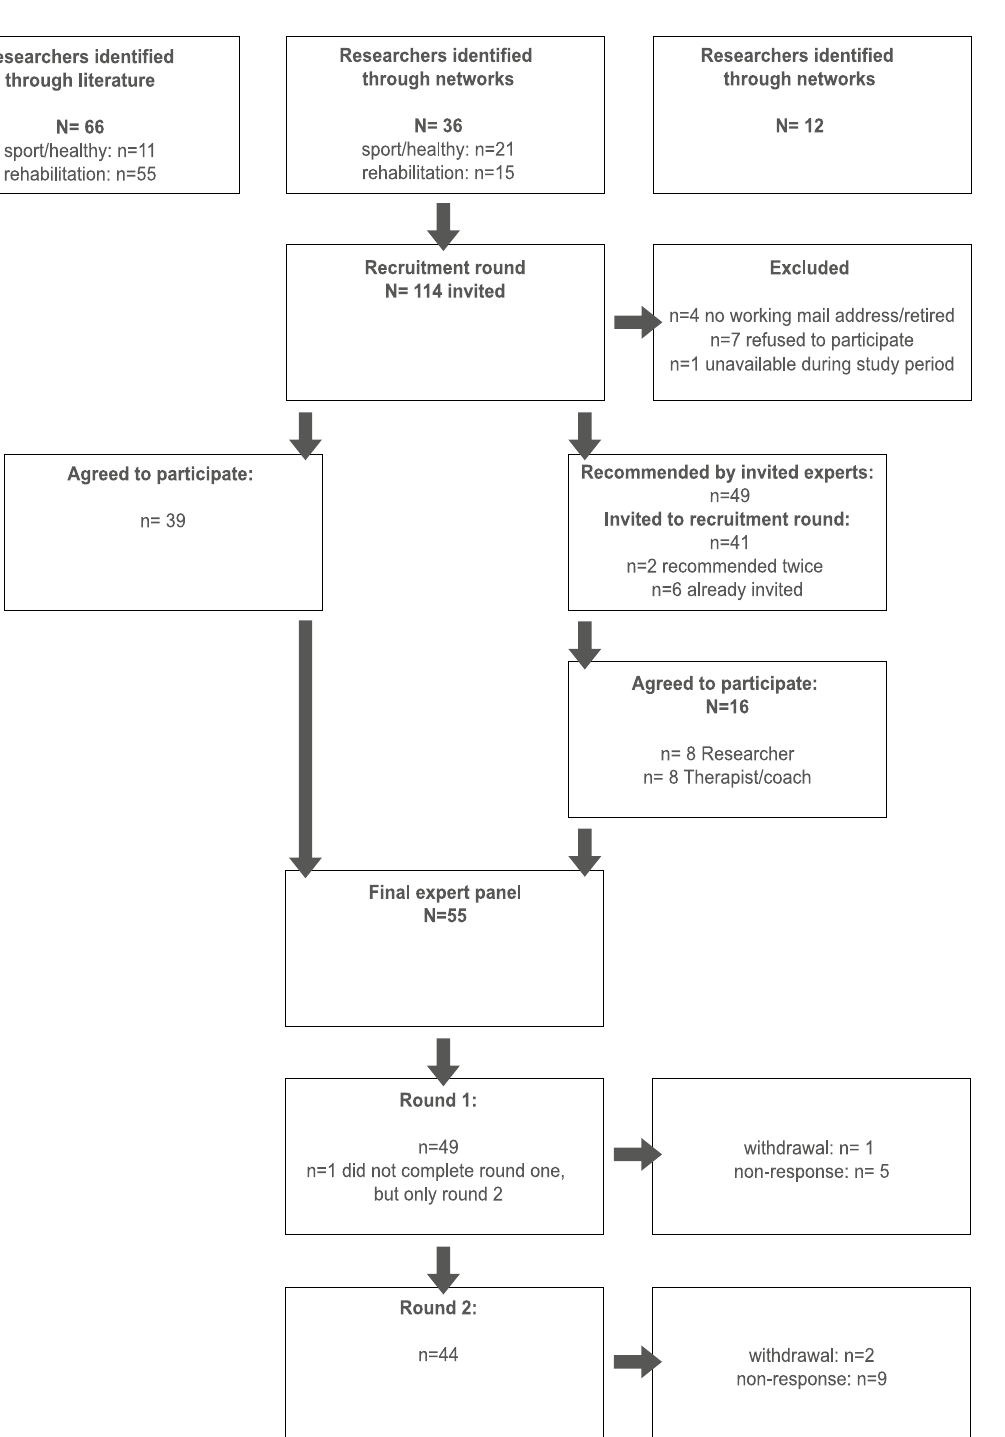
Figure 1. Recruitment and compilation of experts.